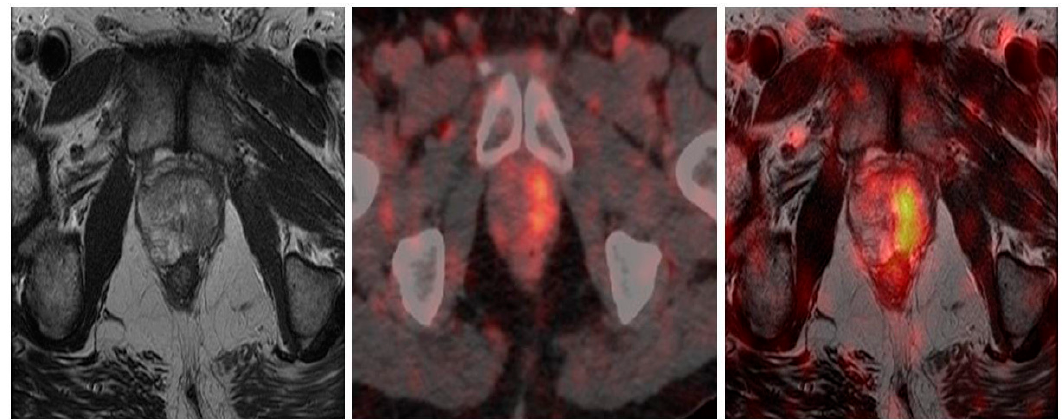
Figure 3. Primary prostate cancer. PIRADS 4/5 left lobe of prostate on multiparametric MRI. Fused to 68 Ga-PSMA PET/CT images for MRI in-bore guided targeted biopsy.